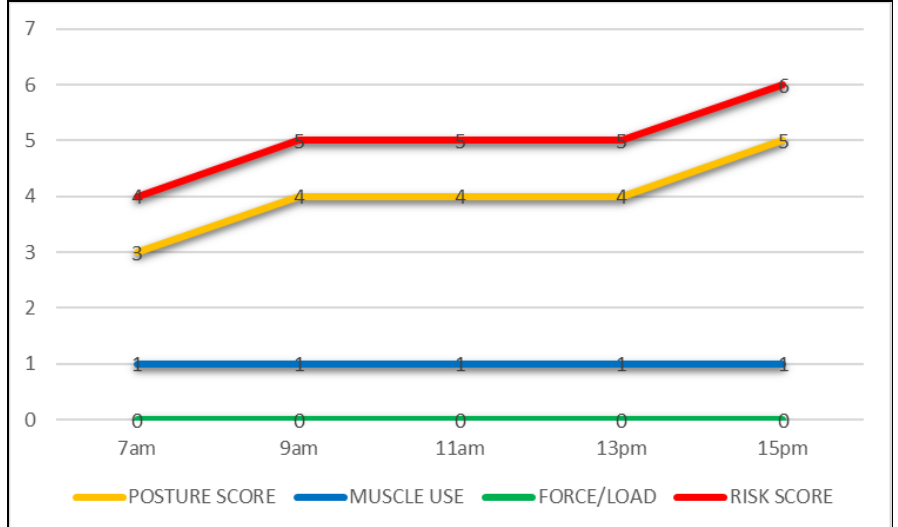
Figure 3. The graph shows the progression of ergonomics risk true